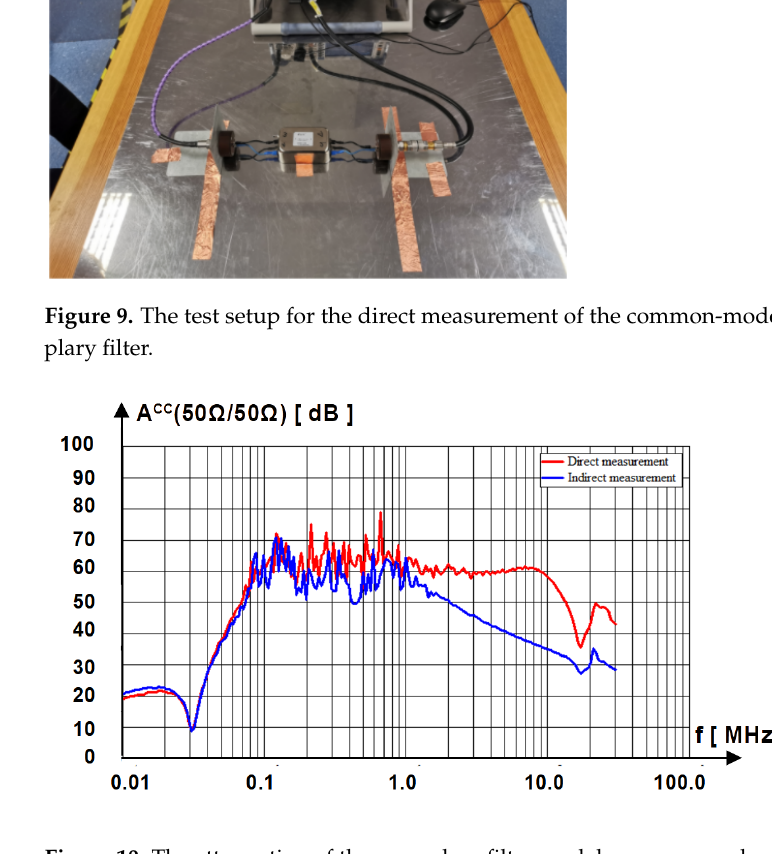
Figure 10. The attenuation of the exemplary filter modal common mode.